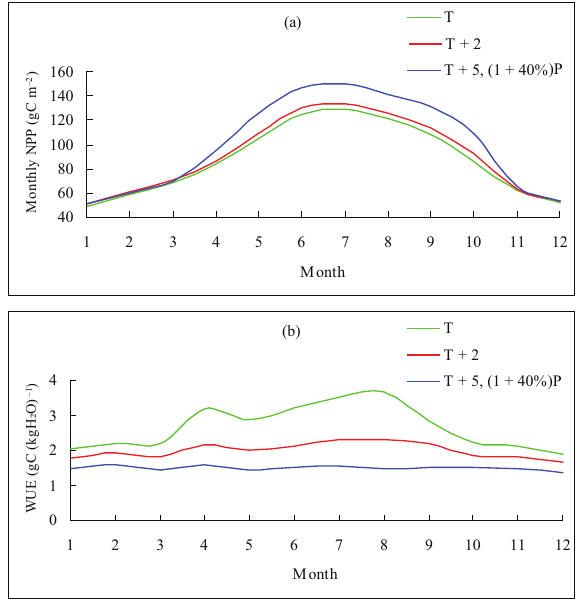
Figure 9. Mean monthly NPP and WUE averaged over the last five years: (a) NPP; and (b)